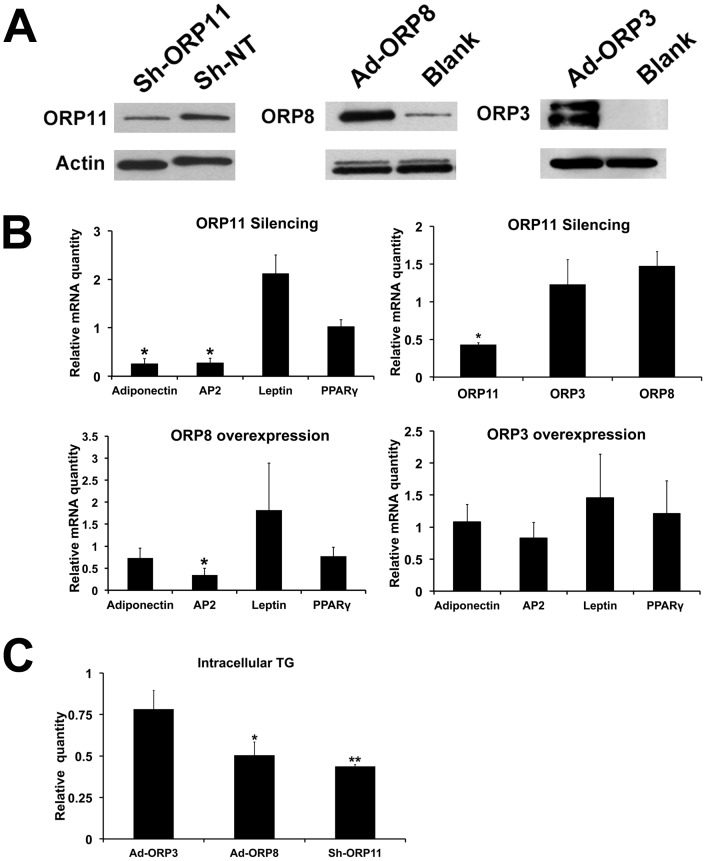
Impacts of ORP manipulation on SGBS cell adipogenic differentiation.ORP8 or ORP3 were overexpressed by infecting cells on day 10 with control (Blank) or ORP (Ad-ORP8, Ad-ORP3) adenoviral vectors, and collected for analysis on day 13. SGBS preadipocytes were transduced with an ORP11 shRNA (Sh-ORP11) or non-targeting (Sh-NT) shRNA lentivirus, followed by differentiation for 22 days. A. Western blots of total cell protein (10 µg/lane); ORP11, after 22 days of differentiation; ORP8 and ORP3, after 72 h of adenoviral transduction. The blots were probed with anti-β-actin as a loading control. B. The impacts of ORP11 silencing or ORP8/ORP3 overexpression on the mRNA levels of adipocyte differentiation markers adiponectin, aP2, leptin and PPARγ. In cells with ORP11 stably silenced also ORP8 and ORP3 mRNAs were quantified. The results are shown as fold changes relative to cells infected with the corresponding control viruses, and represent mean ± S.E., n = 3; *p<0.05. C. The cellular triglyceride concentration was measured by using an enzymatic assay. The results were normalized for total cell protein and are presented relative to cells infected with the corresponding control viruses (mean ± S.E., n = 3; *p<0.05, **p<0.01).